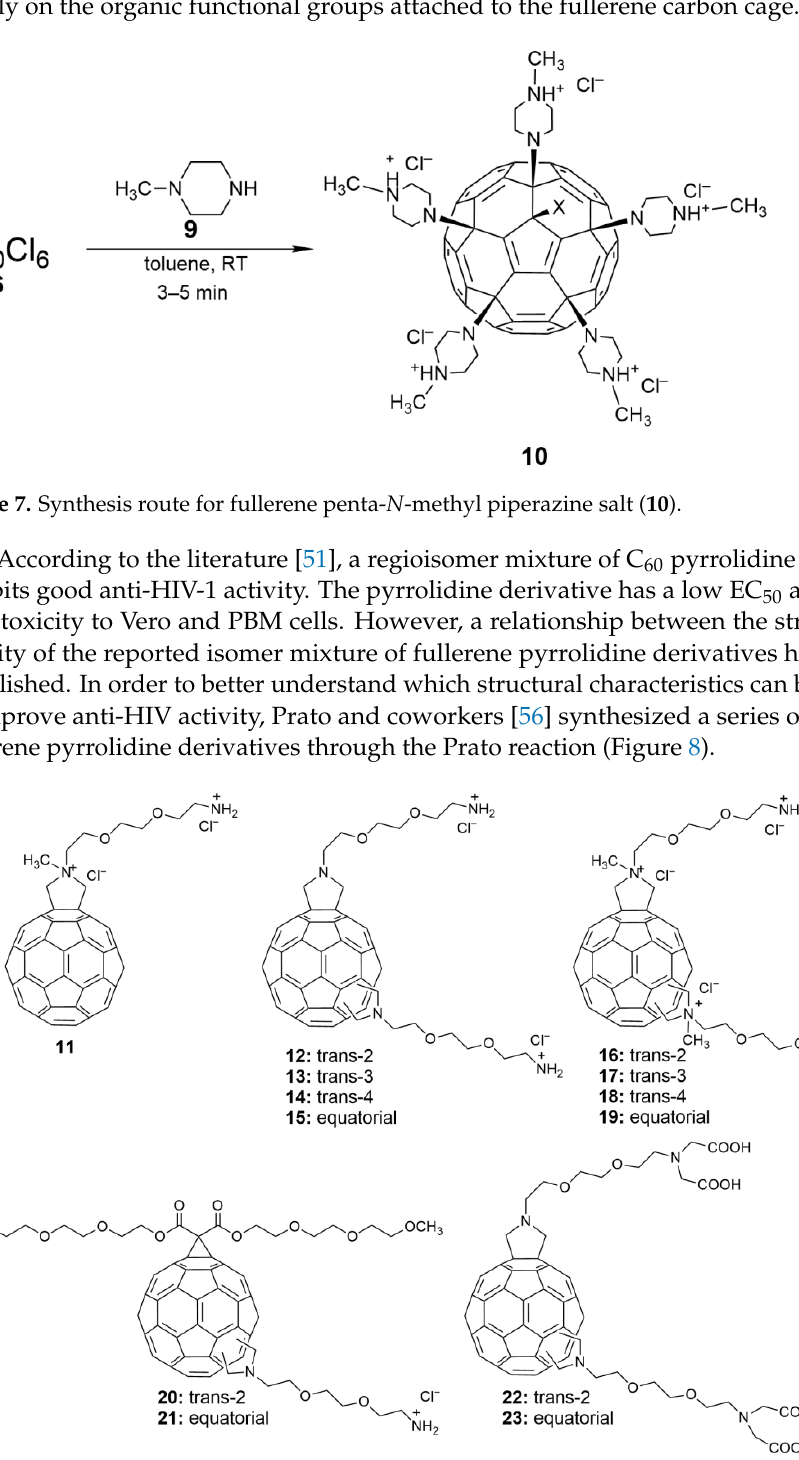
Figure 8. Structure diagram of fullerene pyrrolidine derivatives ( 11 – 23 ).